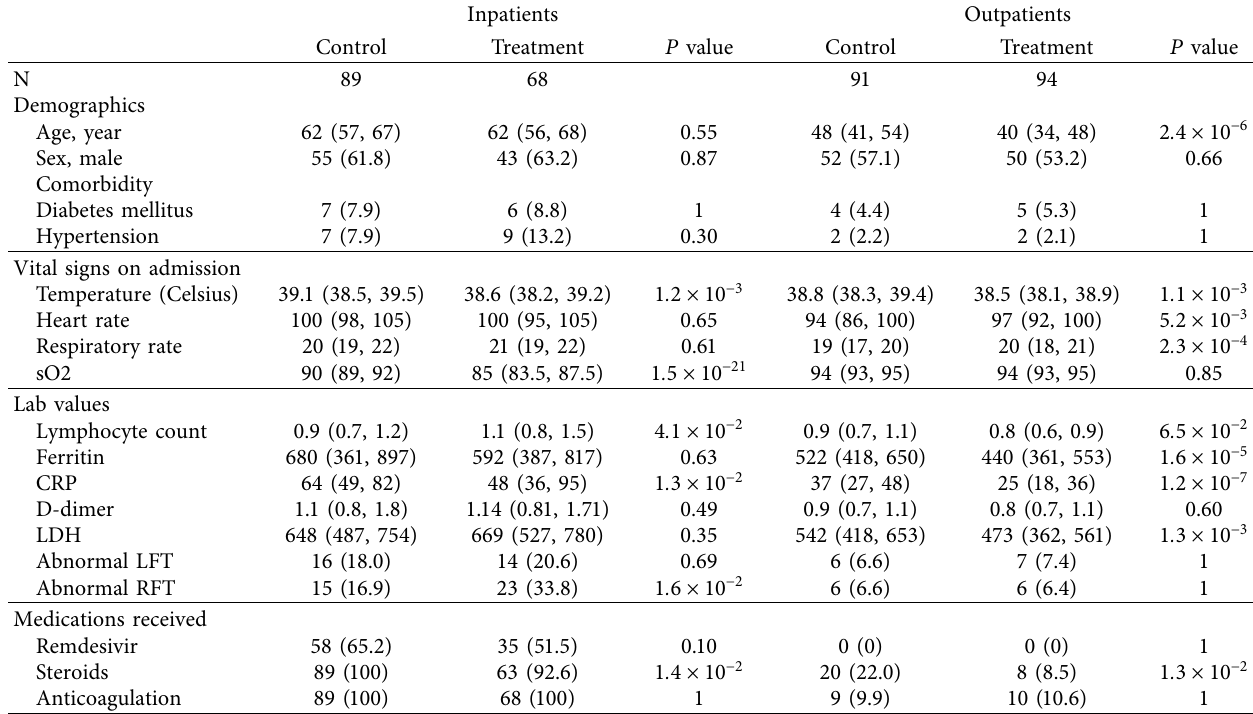
Table 1: Demographics and clinical variables of the mebendazole treatment group and nonmebendazole treatment group for both in- patients and outpatients.